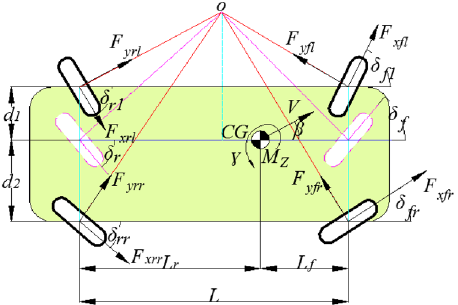
Figure 1. Schematic diagram of the AGV